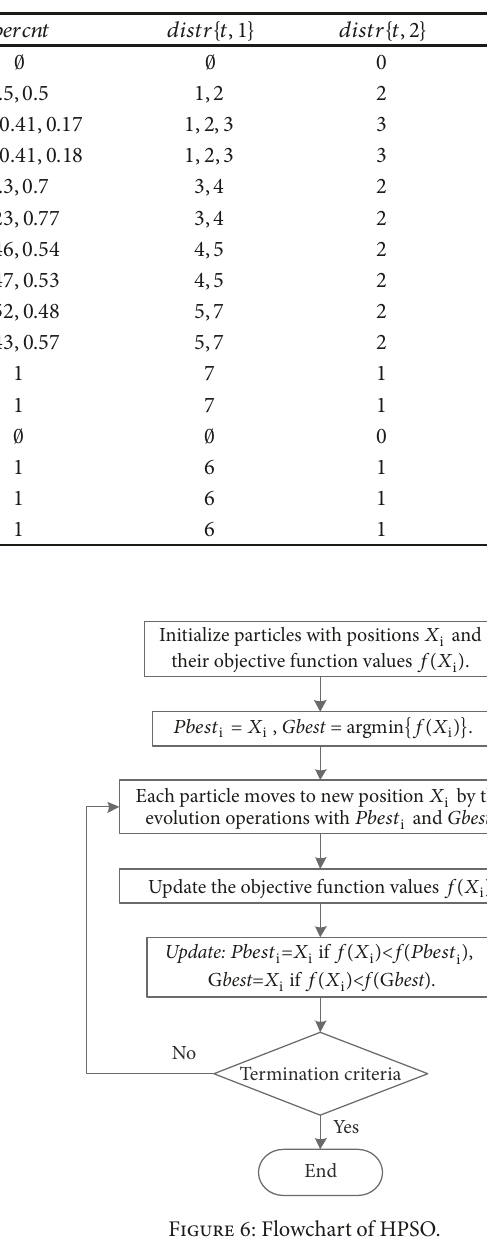
Table 1: An example for Algorithm 2.